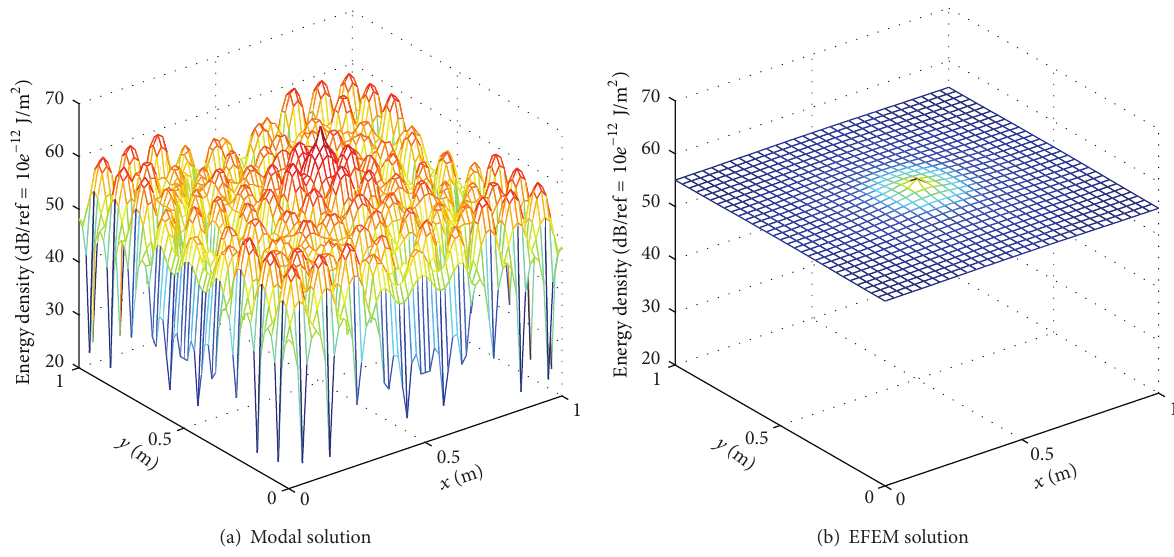
Figure 4: The energy density distributions of the plate in case 1 calculated by both modal superposition method and EFEM.